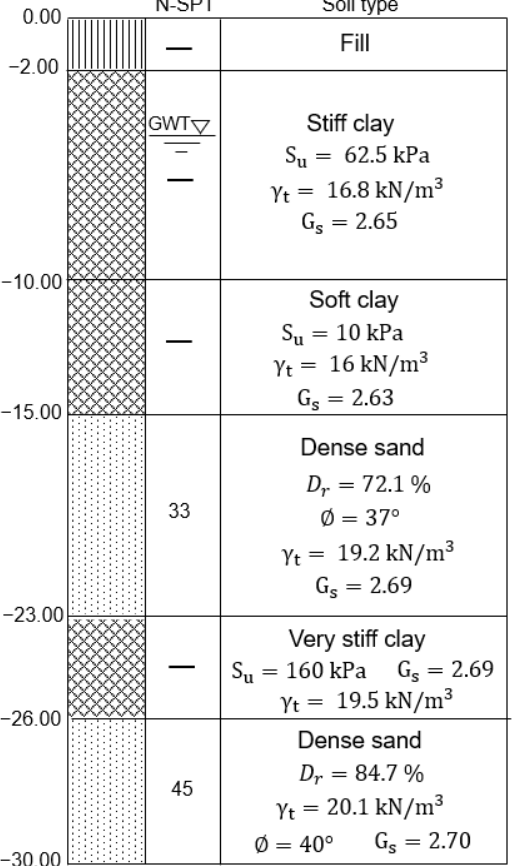
Figure 3. Schematic section of the soil profile around the building under investigation. Note: S u , undrained cohesion; ∅ , internal friction angle; γ t , total unit weight; G s , specific gravity; D r , relative density.